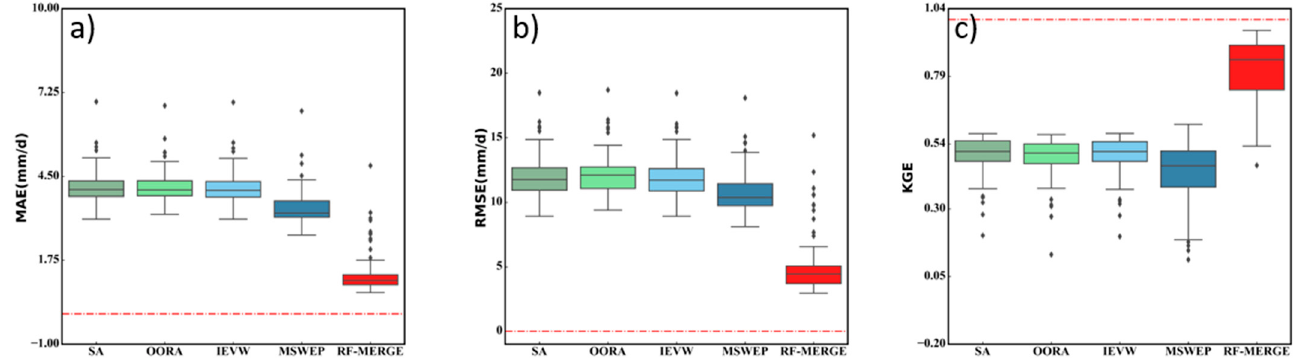
Figure 7. Evaluation of the performance of difference merging approach using ( a ) MAE, ( b ) RMSE, and ( c ) KGE at daily temporal scale over South Korea.